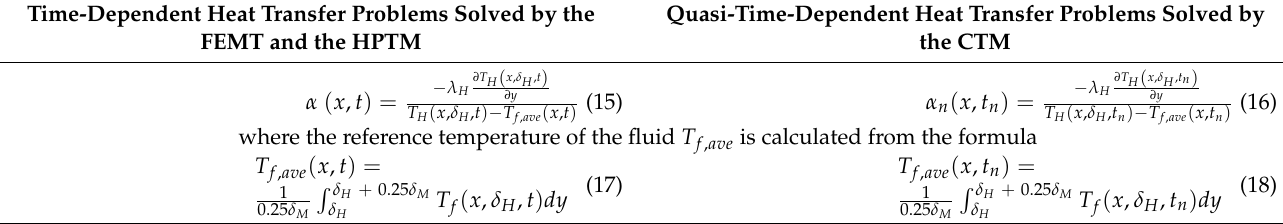
Table 2. Heat transfer coefficient